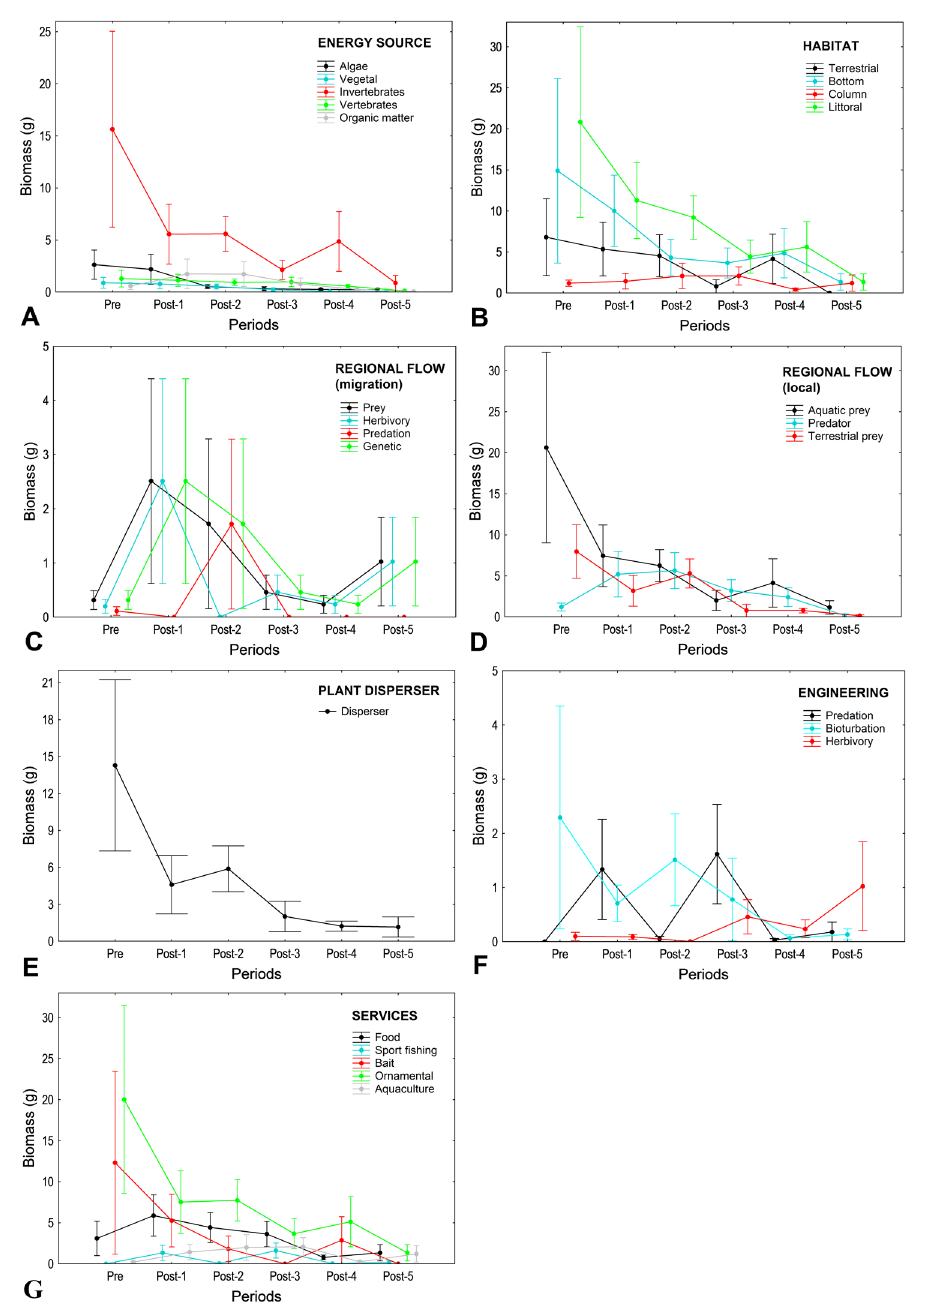
FIGURE 3 | Ecosystem functions generated by fish populations associated with macrophyte beds in Rosana Reservoir, before (Pre) and after (Post 1 to 5) the introduction of Cichla kelberi . Mean ± standard error. Ecosystem functions: A. Energy Source; B. Habitat; C. Regional Flow (migration); D. Regional Flow (local); E. Plant Disperser; F. Engineering; G.